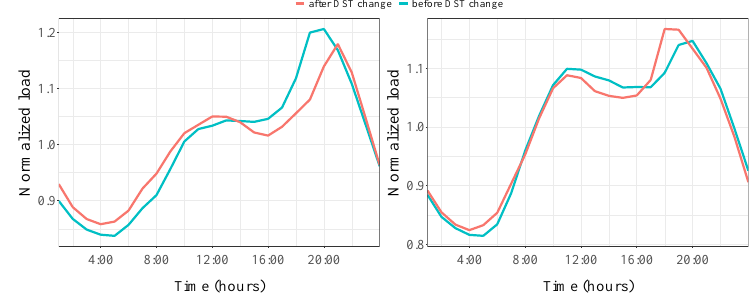
Figure 2. Daylight saving time effect for the year 2013, for the NYC zone. Changes in the load caused by DST for different times in the day are related to the daylight period, which, for a certain region, depends on the time of the year. According to [37], it can be expected that the DST-induced changes are, also, specific for each day of the week. To include the DST load effect, we first adopted the daily binary variable, DS, set to 1 for all days between clock changes in March and October, while for other days, its value was 0. Next, we added a smooth, nonlinear difference to the yearly and weekly profiles with the terms DS x f y ( year ) and DS x f w ( week ) ,